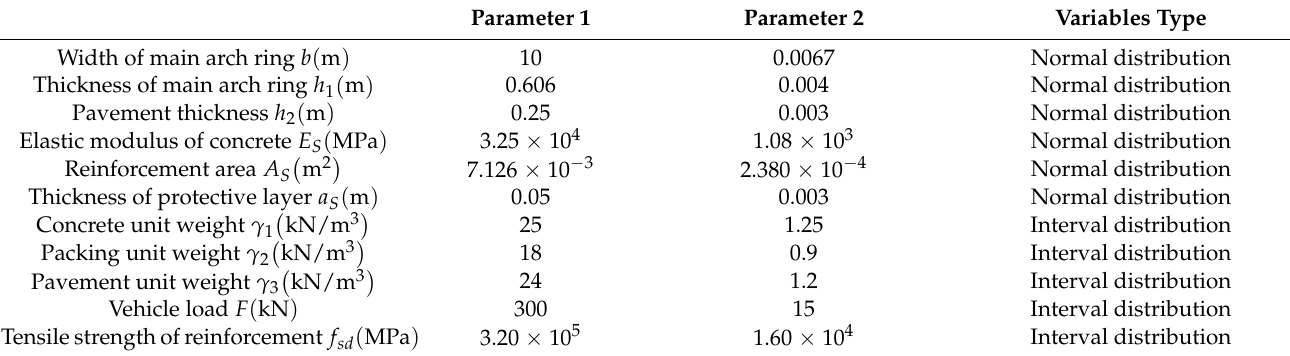
Table 8. Values of the basic parameters in Section